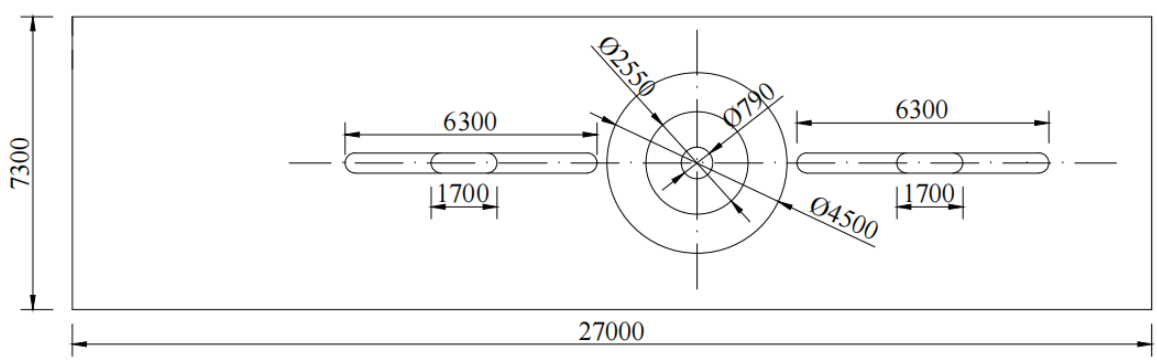
Figure 2. Three-dimensional model of the Impeller.